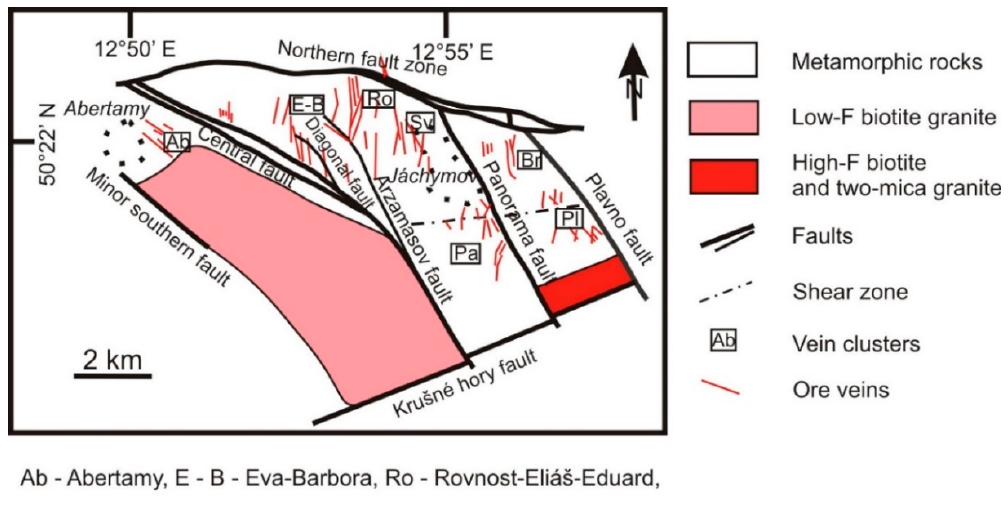
Figure 3. Schematic geological map of the Jáchymov uranium district (modified from Komínek et al. [24]).